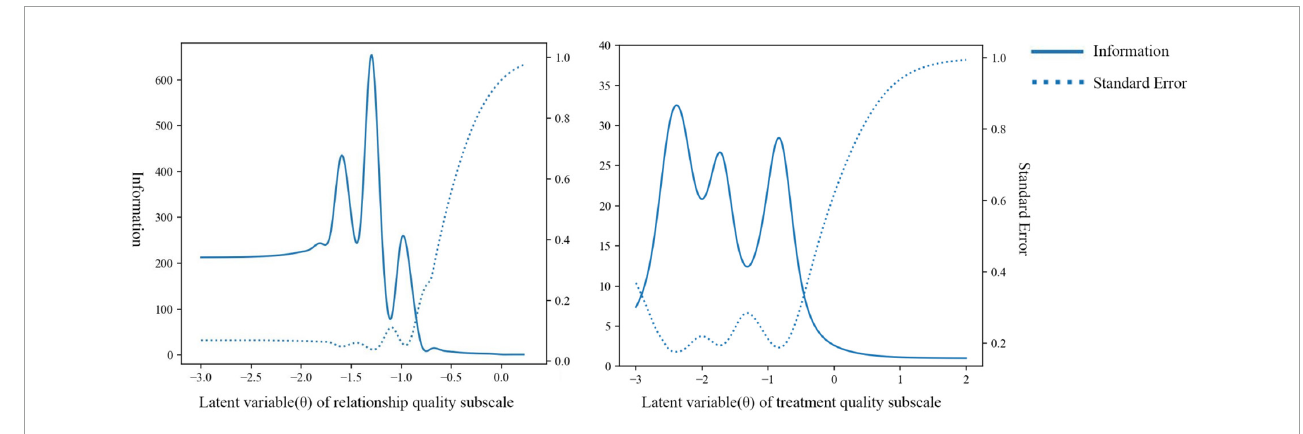
FIGURE3 Item information curves of PDRQ-9